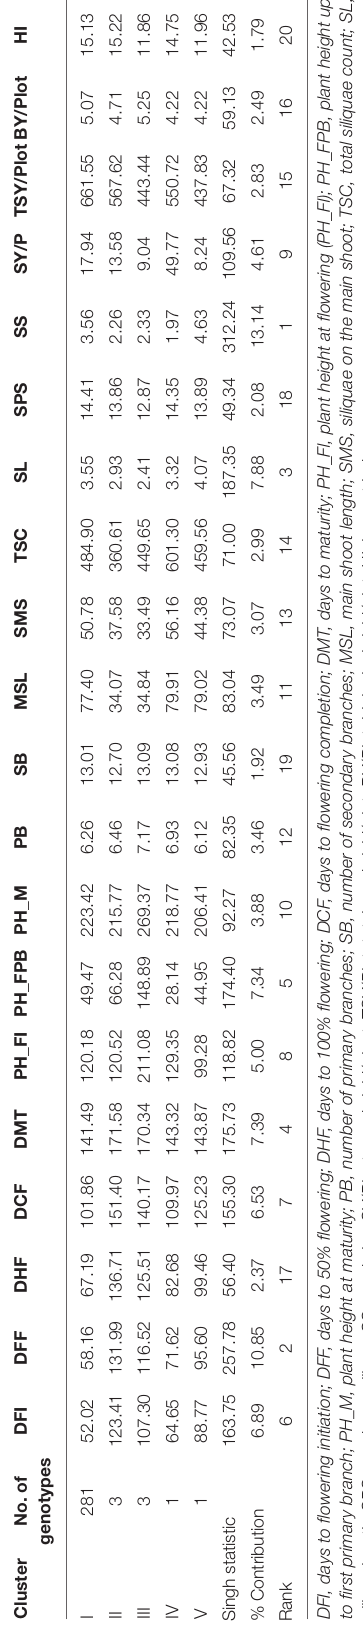
FIGURE 5 | Intra- and inter-cluster distance based on D -value for Indian mustard genotypes.